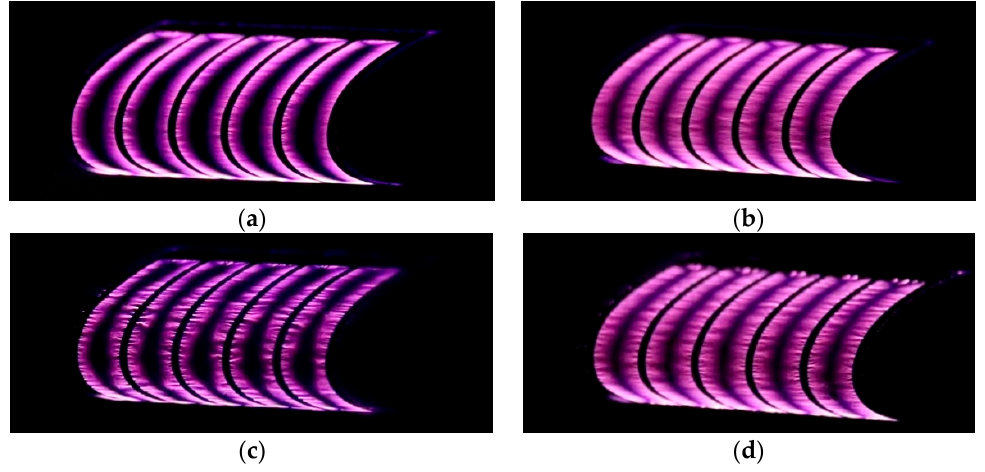
Figure 6. Discharge morphology of NS-DBD: ( a ) LV-HF discharge without impingement from supercooled water droplets; ( b ) HV-LF discharge without impingement from supercooled water droplets; ( c ) LV-HF discharge with impingement from supercooled water droplets; ( d ) LV-HF discharge with impingement from supercooled water droplets.